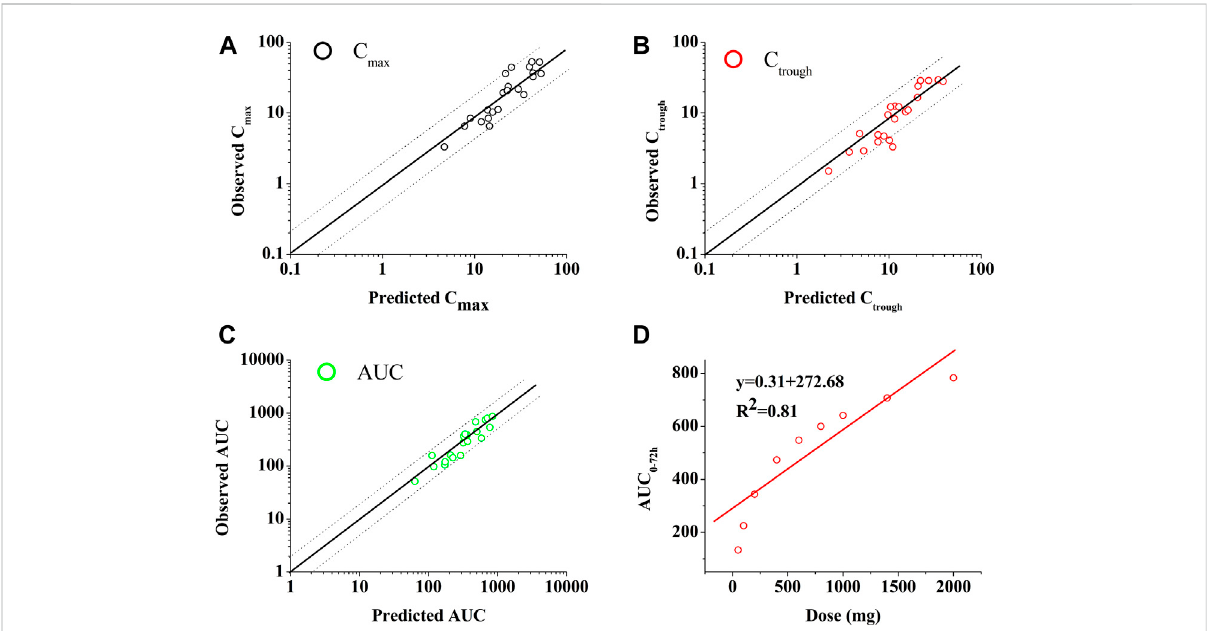
FIGURE 3 Goodness-of- fi tplot ofthePBPKmode ofPAZ for predicted and observed C max (A) , C trough (B) and AUC (C) and relationshipbetween doseand AUC (D). The identity line and acceptable limits (0.5 – 2.0 fold) are shown as solid and dashed lines, respectively. (A,B,C) The black circles ( ○ ), red circles ( ○ ) and green circles ( ○ ) represent the ratios of C max , C trough and AUC , respectively, between prediction and observation. (D) The data ( ○ ) represents the predicted values using the PBPK model. The red solid line via the data points re fl ects the best fi t by the line